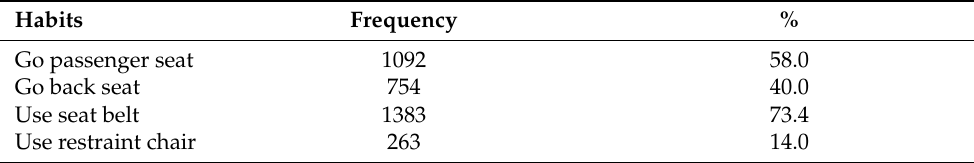
Table 9. Student habits when traveling by car.